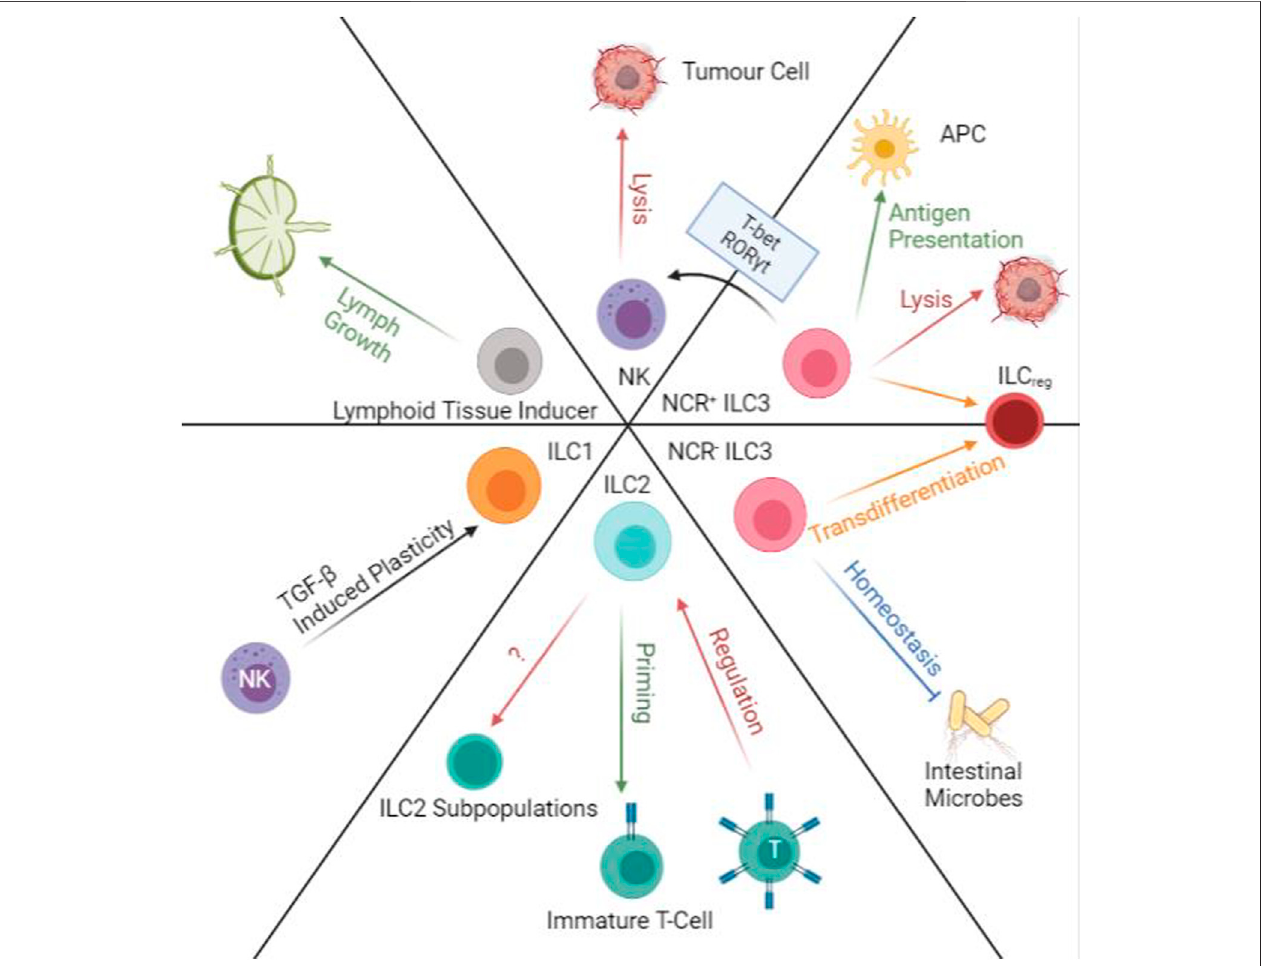
FIGURE 4 | Transdifferentiation and Immunoregulatory Functions of ILCs. ILC1 and NKs have TGF- β induced plasticity that will allow ILC1s to produce IFN- γ and TNF- α . ILC2s can prime immature T-cells and at the same time are regulated by primed T-cells in lymph nodes. ILC2 populations are also able to transdifferentiate into subpopulations along with progression of cancers. NCR- ILC3s regulated intestinal microbes while NCR + ILC3s can help antigen presentation. Both populations of ILC3saresusceptibletotransdifferentiationintoILCreg.NCR+ILC3sarealsoabletotransformintoNK-likecellsandperformNKfunctionsinthepresenceofT-bet and ROR γ t. NK cells can directly induce apoptosis on tumour cells. Lymphoid tissue inducers aid lymph growth.